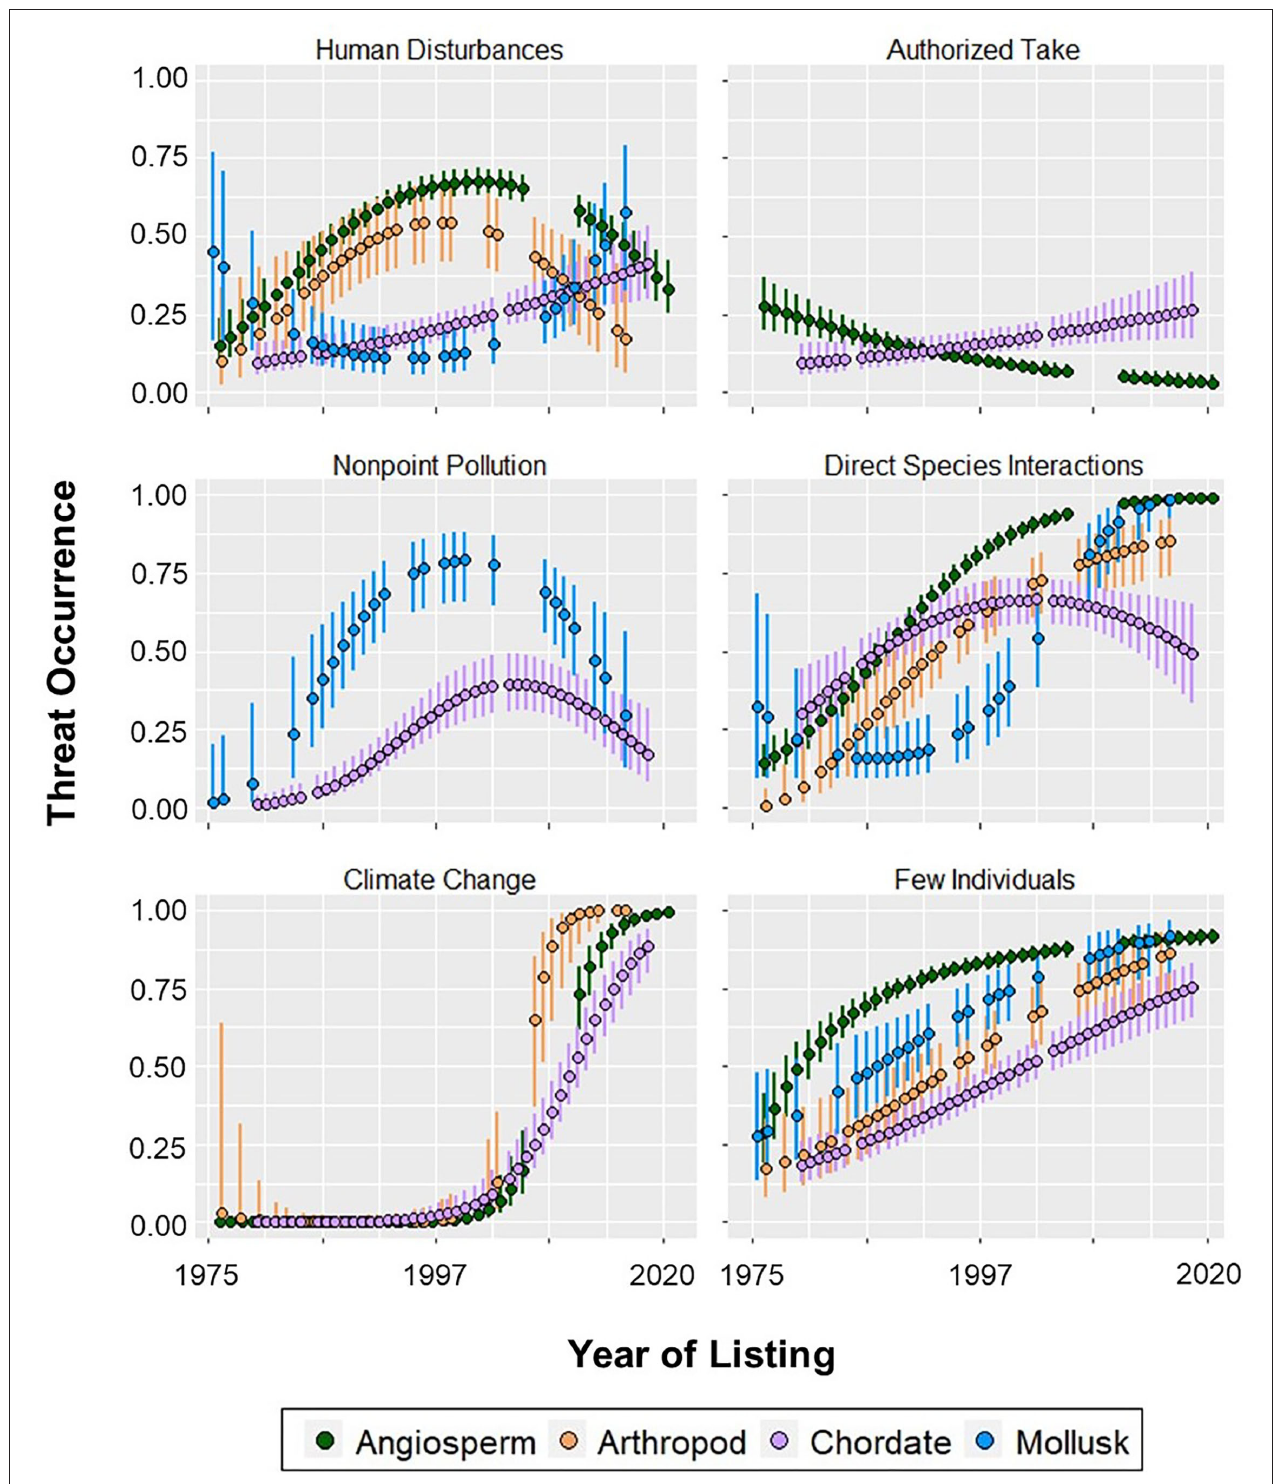
FIGURE 3 | Probability ( ± 95% CI) of threats impacting angiosperm, arthropod, chordate, and mollusk phyla at the time of their listing. Year of listing was scaled and centered for the models.